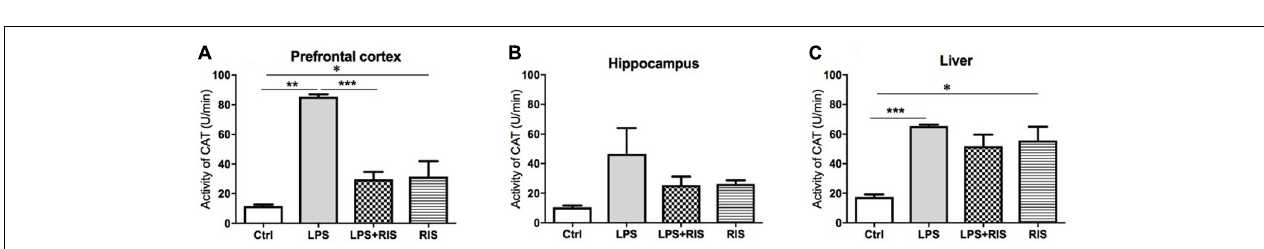
FIGURE 3 | Effect of various treatments on the level of nitric oxide (NO). Groups are Ctrl (control), LPS (lipopolysaccharide), LPS+RIS (lipopolysaccharide + risperidone), and RIS (risperidone). NO was measured from the prefrontal cortex (A) , hippocampus (B) , and liver (C) tissues. Values are represented as mean ± SEM. Post hoc multiple comparison test namely, “Newman–Keuls” test was used to compare between groups. n = 6 per group. ∗ p < 0.05, ∗∗ p < 0.01, ∗∗∗ p < 0.001, ∗∗∗∗ p < 0.0001.